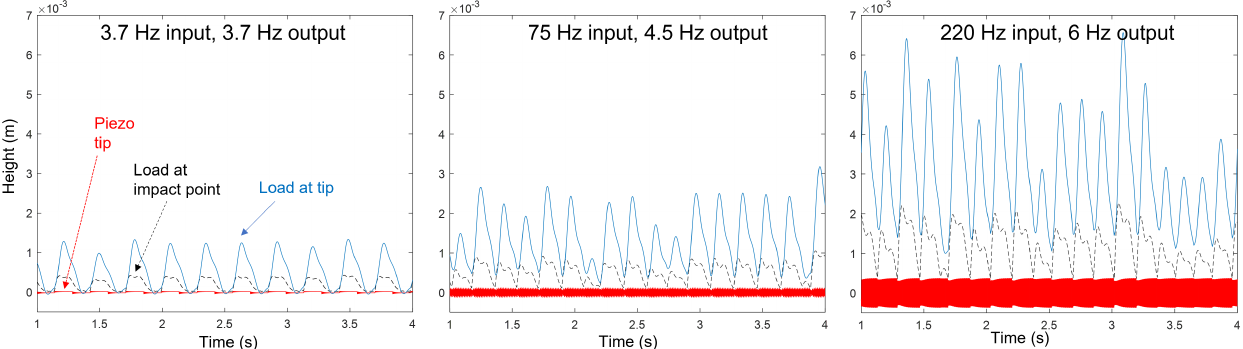
Figure 4. Sample time series simulations at driving frequencies with large output amplitudes, showing interaction between the active PZT element (red), output load at contact point (black), and output load at tip.